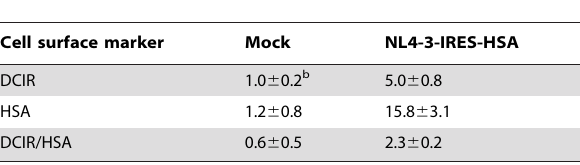
Table 1. HIV-1 induces DCIR expression in CD4 + T cells a